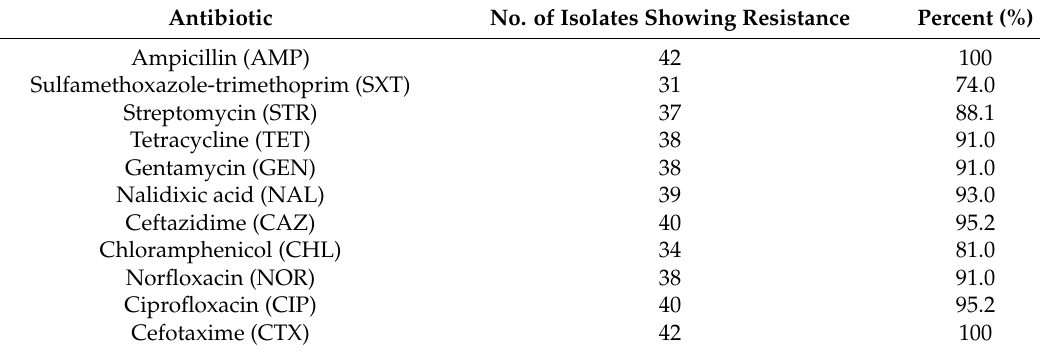
Table 3. Pattern of antimicrobial resistance in bla CTX-M producing E. coli isolates. Antibiotic No. of Isolates Showing